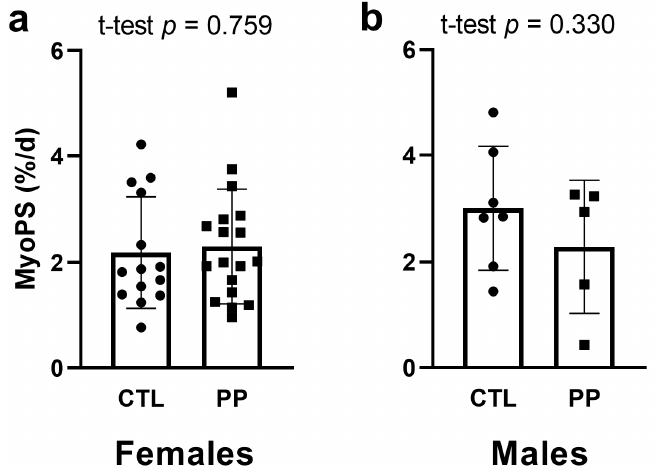
Figure 3. Myofibrillar protein synthesis rates following the first bout of training with or without PP supplementation. Data include myofibrillar protein synthesis rates 24 h following the first exercise bout in females (panel a ) and males (panel b ). All data are presented as mean ± standard deviation values, and individual respondent values are presented as circles (for CTL) and squares (for PP). Abbreviations: PP, peanut protein group; CTL, control group.